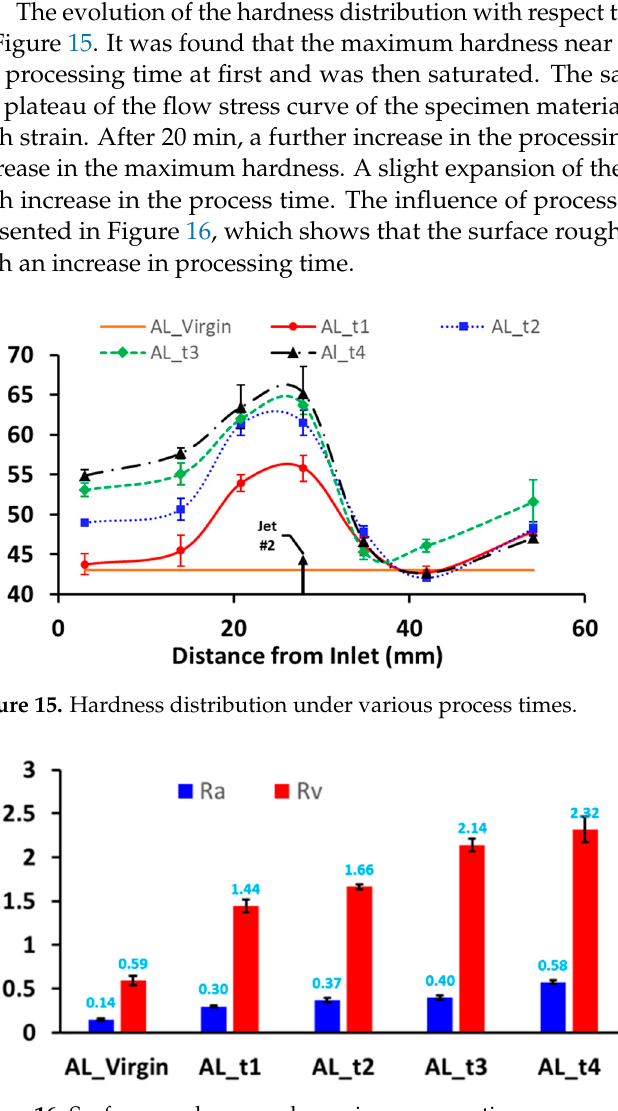
Figure 16. Surface roughness under various process times.